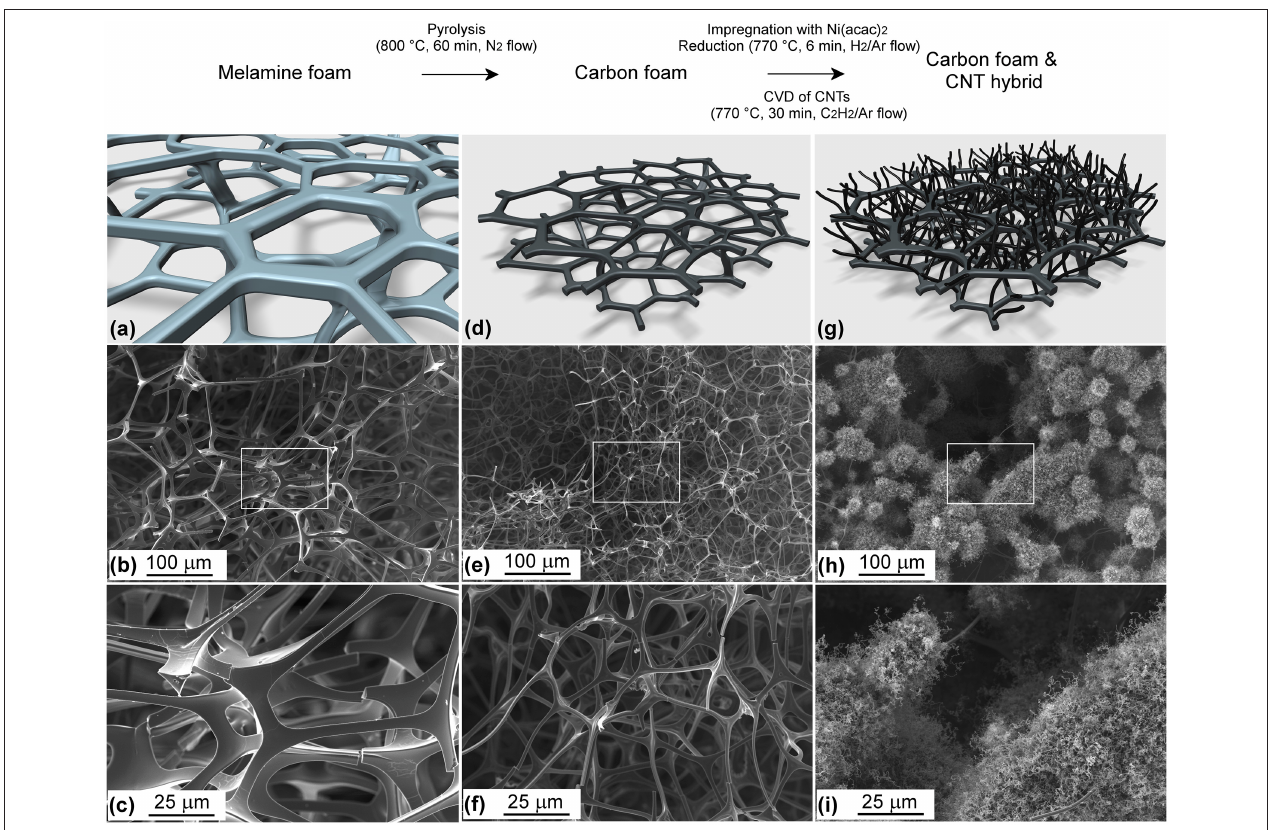
FIGURE 1 | (a,d,g) Schematic drawings of the original open pore structure melamine foam, carbon foam and hierarchical carbon foam and carbon nanotube hybrid, respectively. Panels (b,e,h) show low magnification scanning electron micrographs of the corresponding structures. In panels (c,f,i) magnified images of the samples are shown as indicated by the corresponding white rectangular selected areas in images (b,e,g)